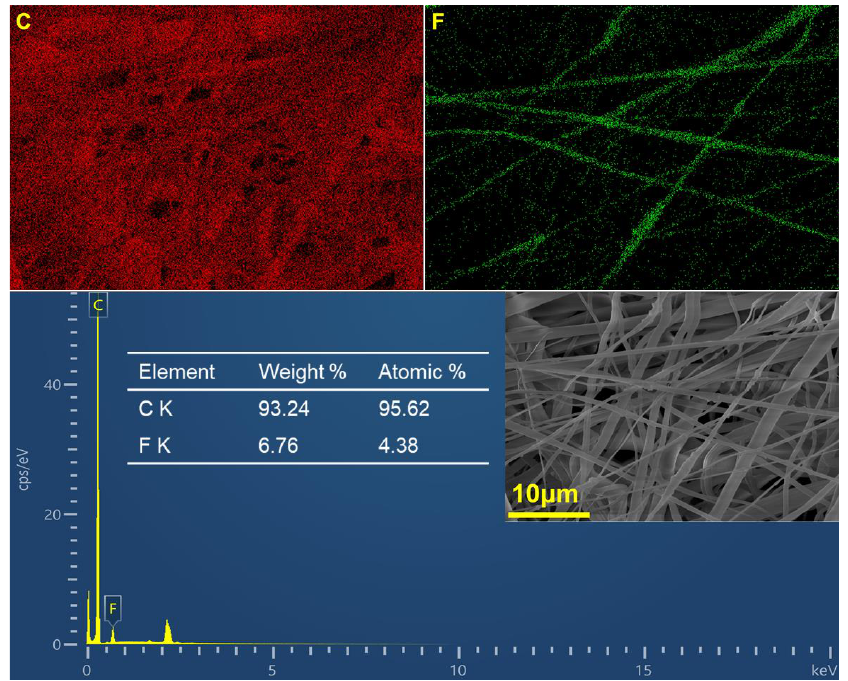
Figure 4. EDX images of the composite